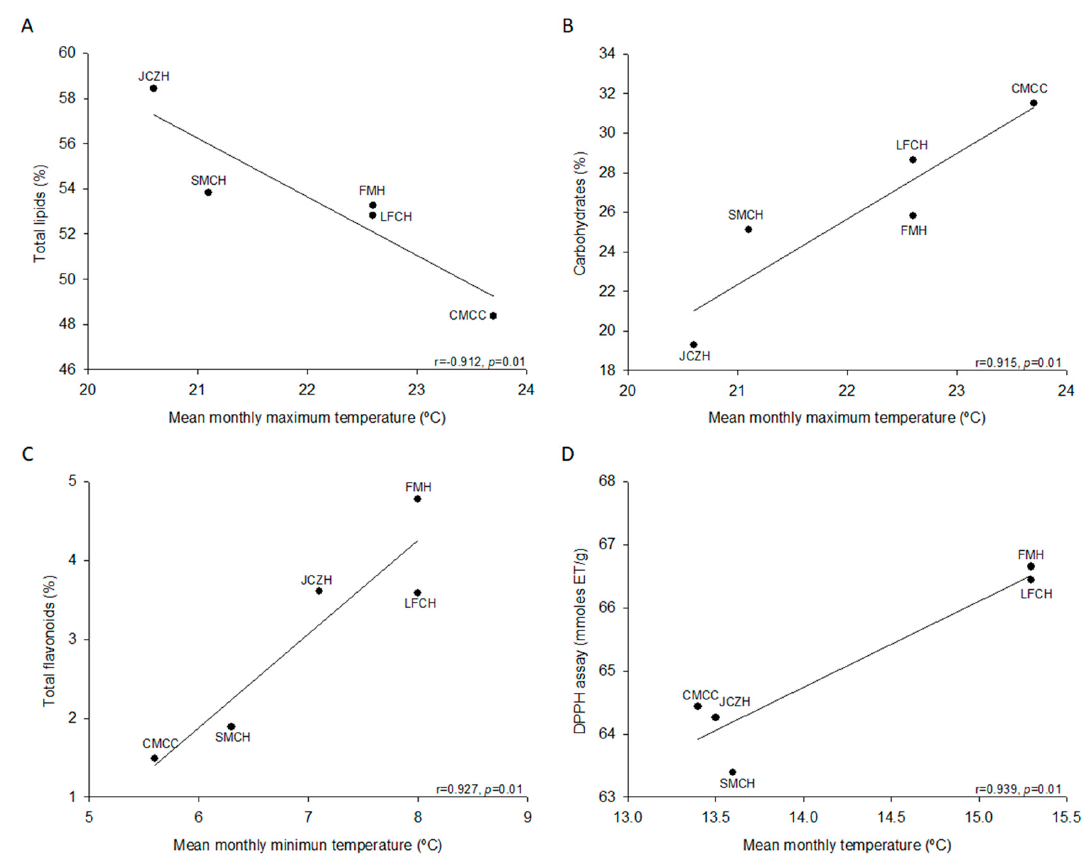
Figure 2. Correlation between chemical composition and climatic data. ( A ) Total lipids. ( B ) Carbohydrates correlated with mean monthly maximum temperature. ( C ) Total flavonoids correlated with the mean monthly minimum temperature. ( D ) DPPH assay correlated with the mean monthly temperature. Pearson’s correlation coefficient is indicated with a level of significance ( p ≤ 0.05). Population names are indicated in Table 4.